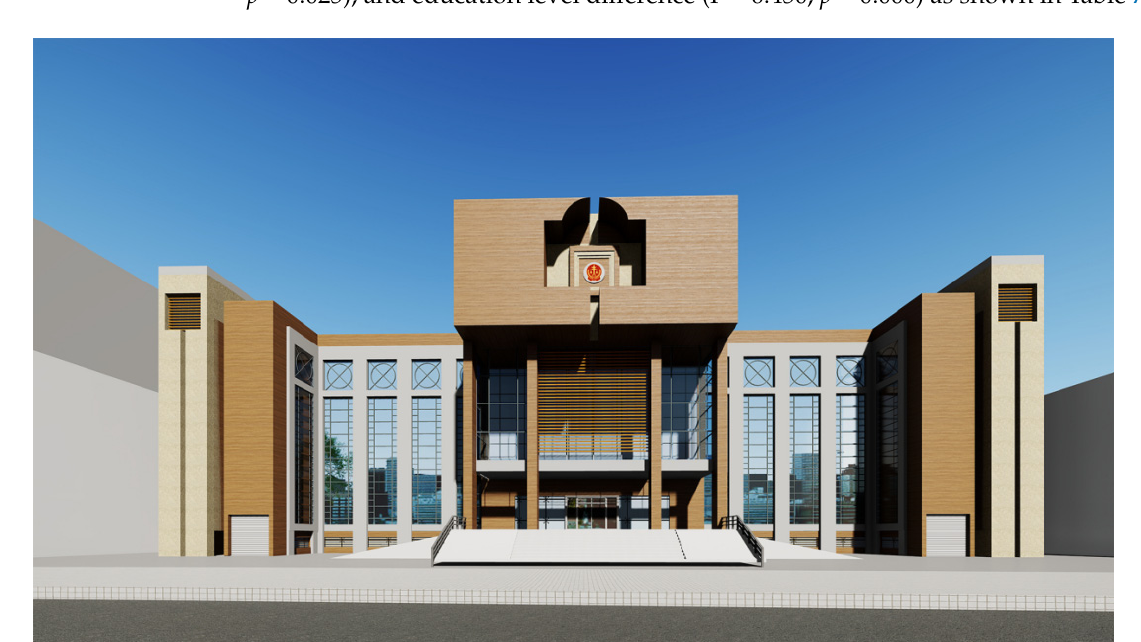
Figure 4. The photo with the highest mean score (No.6).